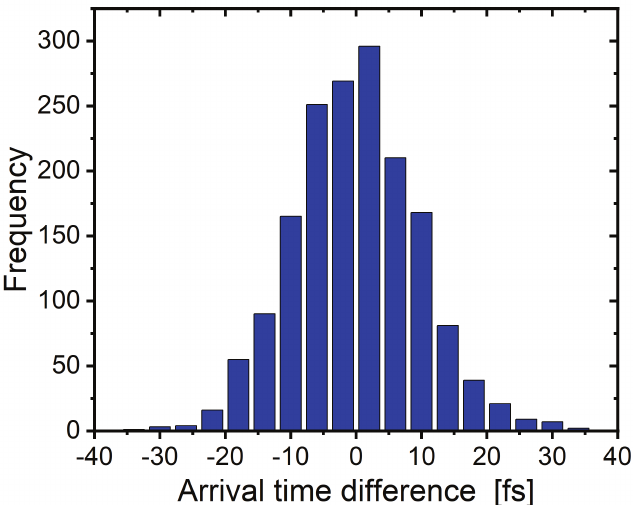
Figure 11. Histogram of the relative arrival time fluctuations between the two pulses. For the used FEL parameters, we found a ∼ 10 fs rms fluctuation of the relative arrival